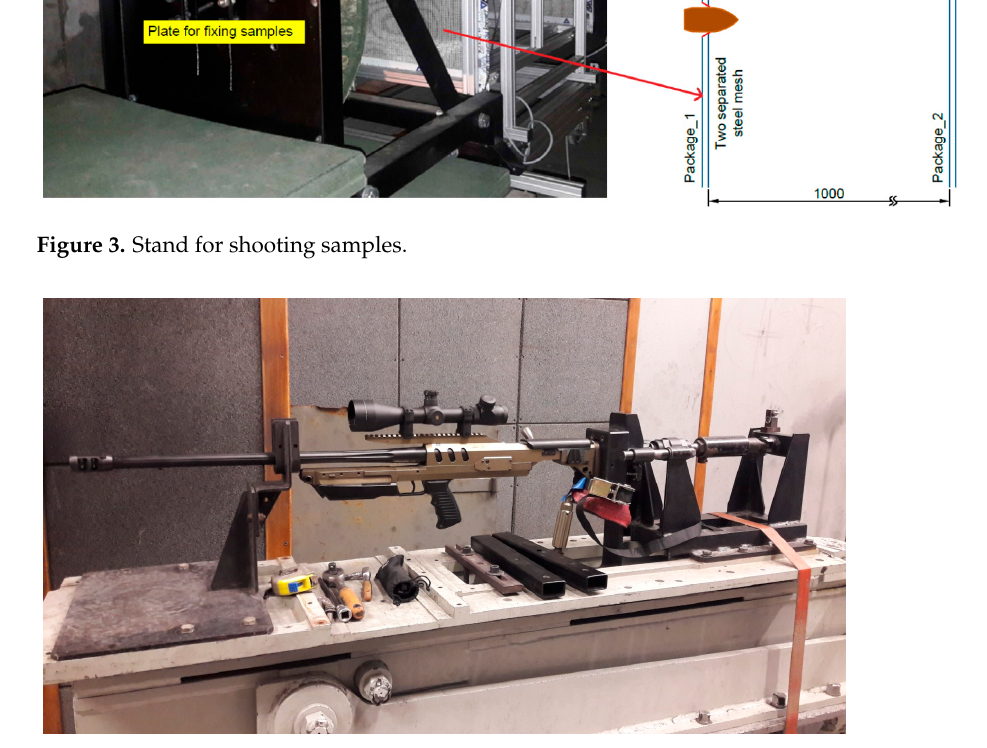
Figure 4. Launcher with mounted ALEX .308 riffle.